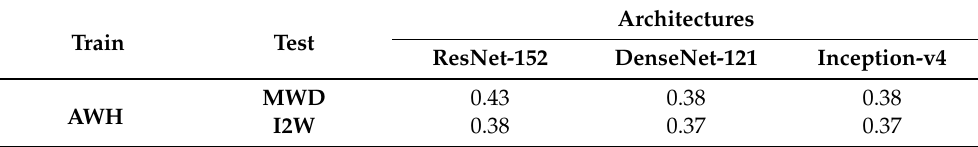
Table 8. Classification results of database transfer from the Cerema-AWH to public databases with 3 meteorological